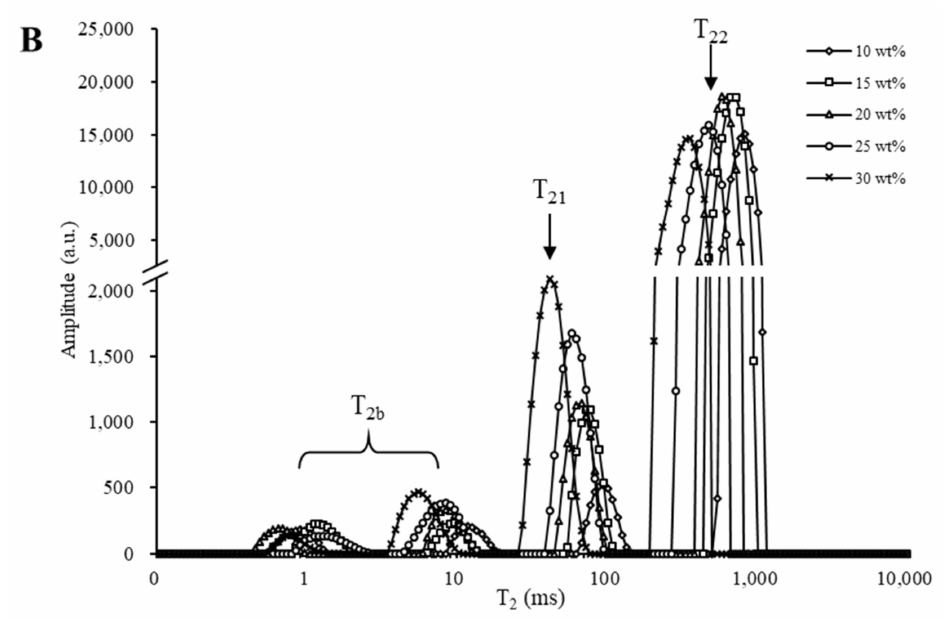
Figure 4. Distribution of T 2 relaxation time of whipped creams with glucose ( A ) and corn syrup ( B ) at different sugar